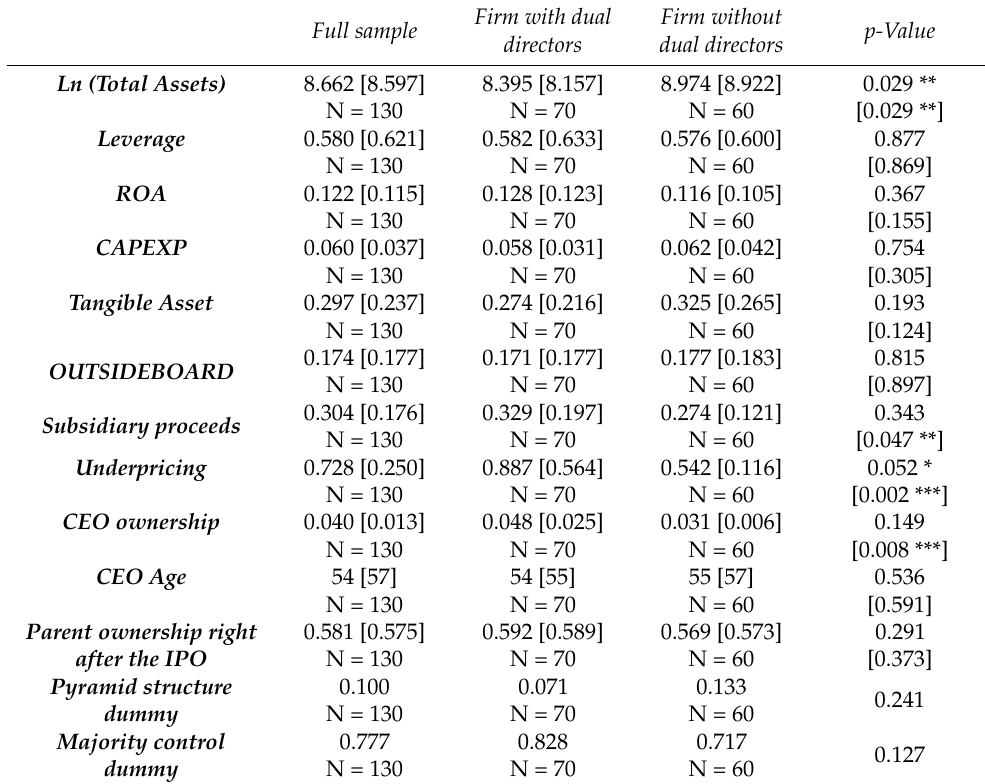
Table 3. Cont. Panel B: Characteristics of carve-out subsidiary